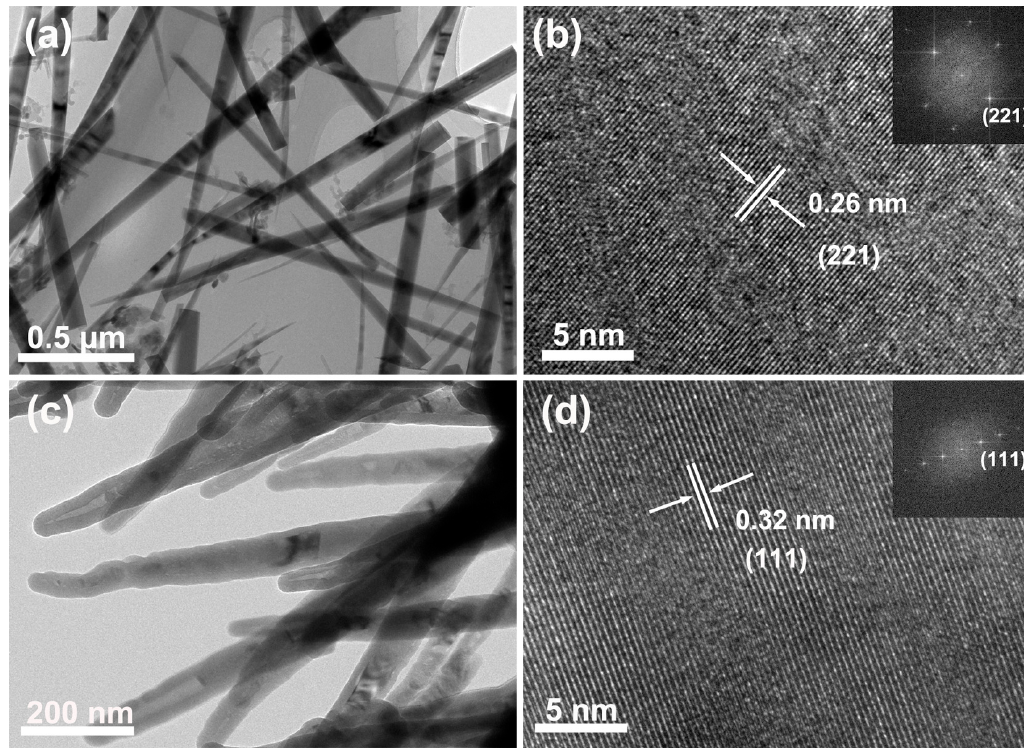
Figure 3. TEM and HRTEM images of the Ni–Co precursor ( a , b ) and final Ni-doped CoS 2 ( c , d ) with a Ni/Co molar ratio of 1:2.